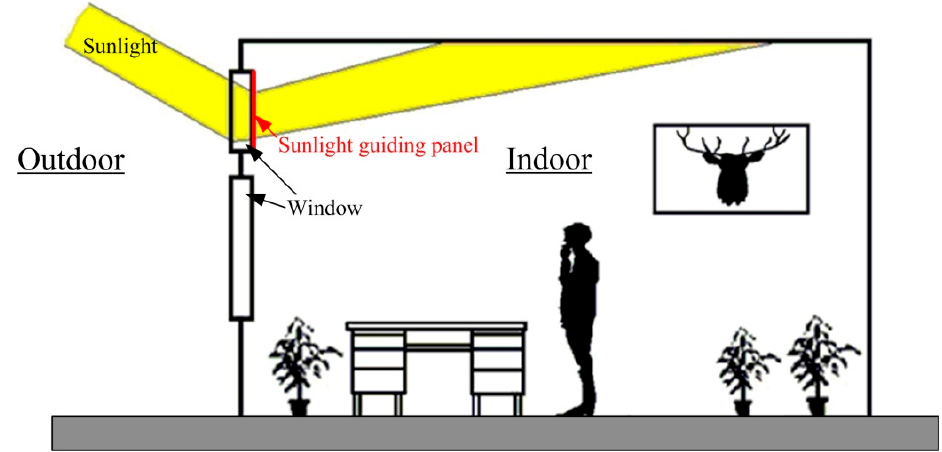
Figure 3. Conceptual design of the proposed sunlight guiding panel.